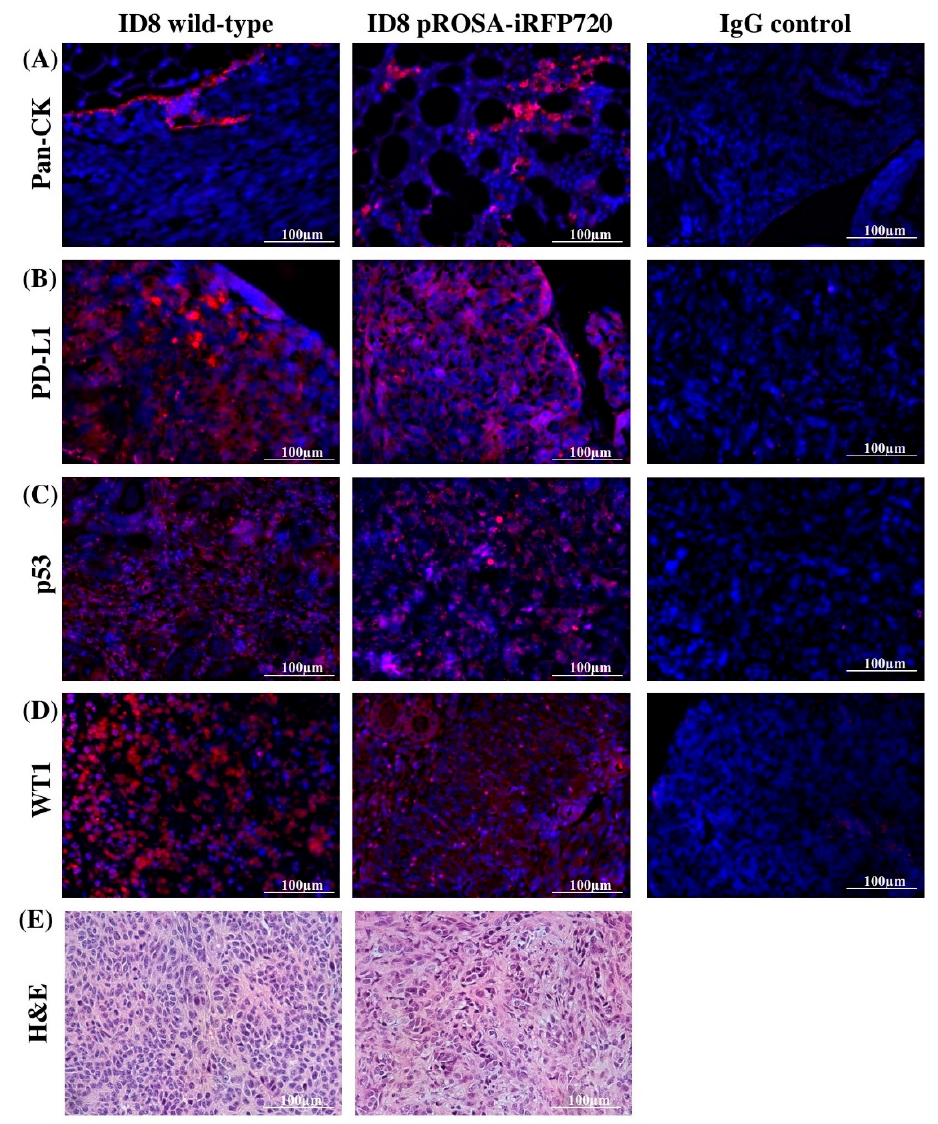
Figure 4. Expression of serous tumour markers by immunofluorescence. Representative fluorescent images of pROSA-iRFP720 and wild-type ID8 ovarian tumour sections stained with ( A ) pan-cytokeratin (pan-CK), ( B ) PD-L1, ( C ) p53 and ( D ) Wilms Tumour protein 1 (WT1). Images were acquired using the Cytation 3 imaging Multi-Mode Reader (BioTek) and were processed using the Gen5™ software v 2.05 (BioTek). Staining appears red against nuclei stained with DAPI (blue). ( E ) Wild-type and pROSA-iRFP720 ID8 ovarian tumour sections stained with hematoxylin and eosin (H&E).